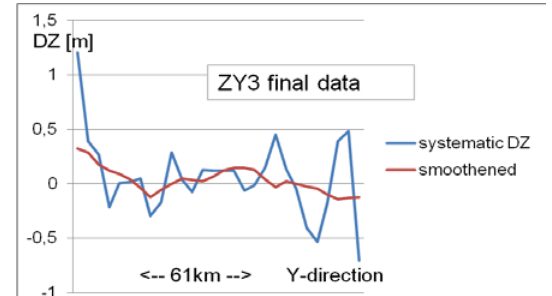
Figure 10. Systematic height errors in Y-direction,